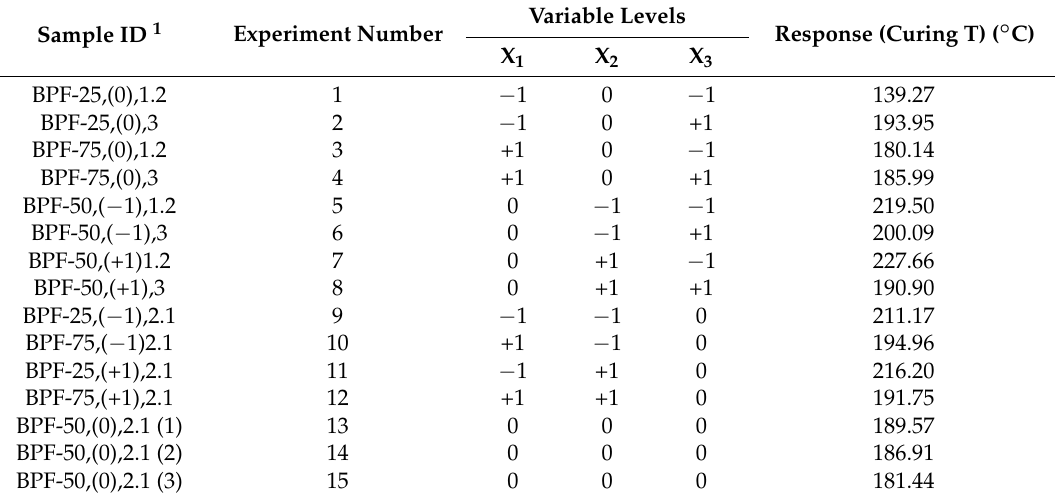
Table 7. BBD Matrix for the effect of phenol-to-lignin substitution, (X 1 ) Lignin M w (X 2 ). F/P molar ratio (X 3 ) on the Curing Temperature ( ◦ C) of BPF resoles including experimental results.